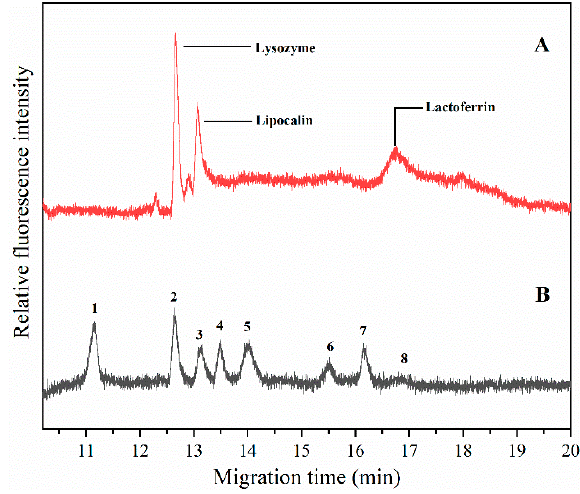
Figure 4. The electropherogram of ( A ) tear proteins and ( B ) protein markers in 1.4% ( m / v ) mixed HEC (1,300,000/250,000), the ratio of the two HEC polymers was 5/5, and other electrophoretic conditions were the same as in Figure 1. The peaks in Figure 4B were characterized as follows: 1. aprotinin bovine pancreas (6.5 kDa), 2. lysozyme (14.3 kDa), 3. trypsin inhibitor (20.1 kDa), 4. carbonic anhydrase (29.0 kDa), 5. ovalbumin (44.3 kDa), 6. serum albumin (66.4 kDa), 7. phos-phorylase B (97.2 kDa), and 8. β -galactosidase (116.0 kDa).